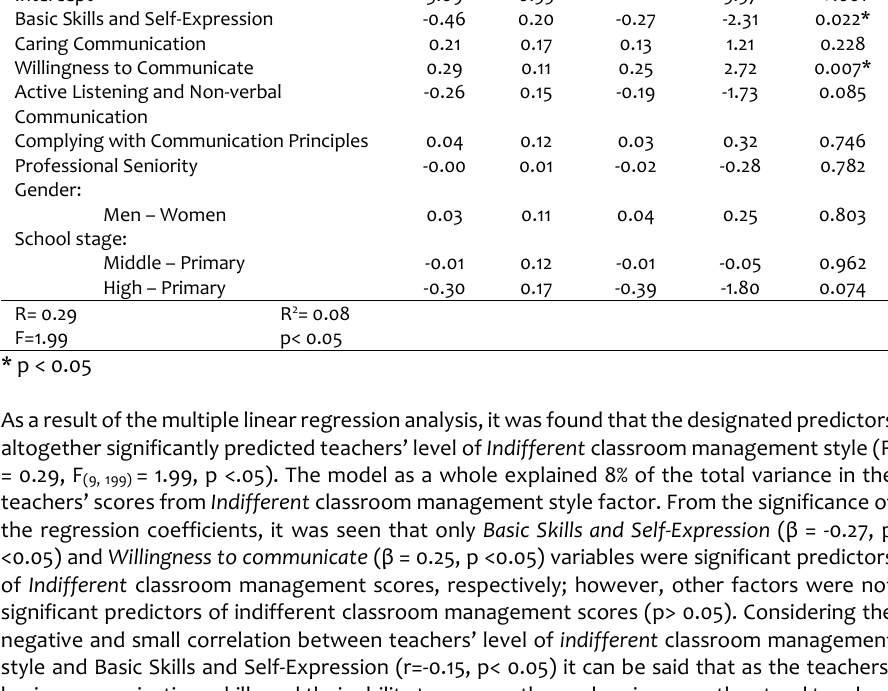
Table 7. Multiple linear regression analysis results for teachers’ level of Indifferent CMS Predictors